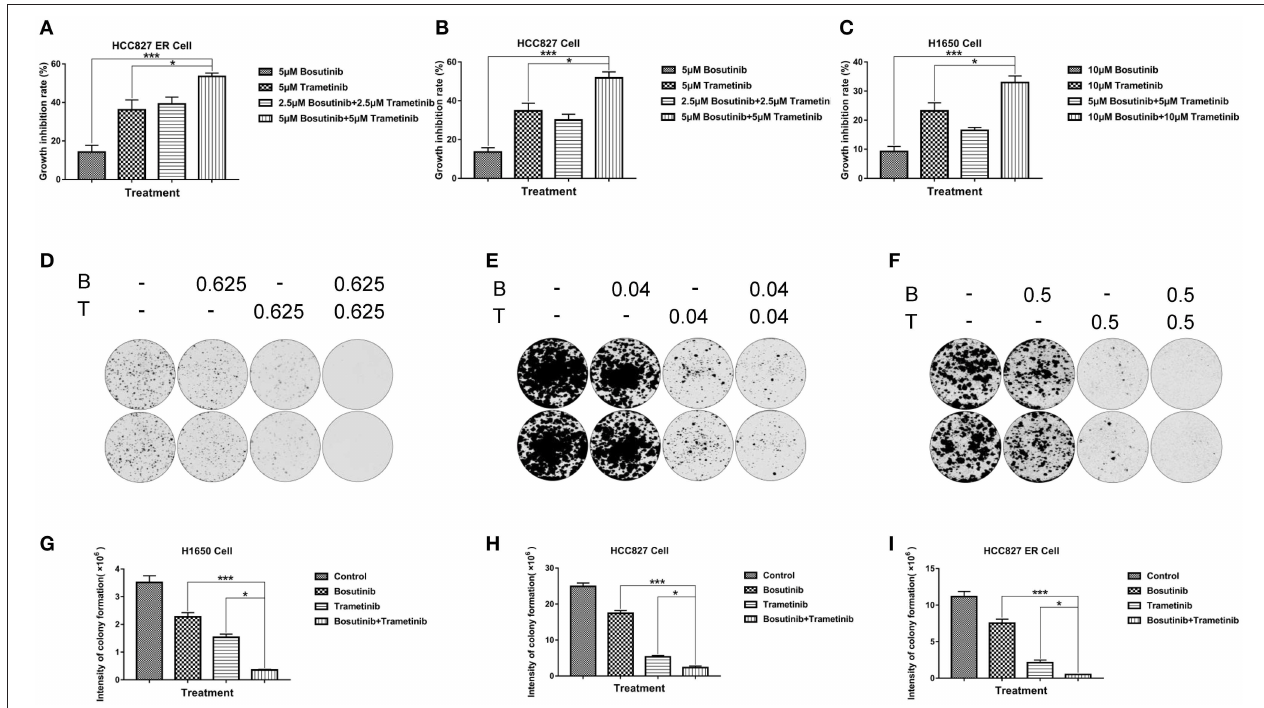
FIGURE 2 | The combination of trametinib with bosutinib synergistically reduced the viability of NSCLC in vitro. (A) H1650, (B) HCC827, and (C) HCC827 ER cell lines were seeded in 96-well plates. Trametinib, bosutinib, or their combination was added for 24h. Cell viability was determined using the MTT assay. (D) H1650, (E) HCC827, and (F) HCC827 ER cell lines were seeded at specific cell densities in six-well plates and were incubated overnight. The cells were treated with different concentrations of trametinib, bosutinib, or their combination for 24h. Then, the media were replaced with complete medium without drugs, and the cells were cultured for 14 days. Histograms of quantitative analysis of the colony formation assay: (G) H1650, (H) HCC827, and (I) HCC827ER cell lines. The data are presented as mean ± S.D. * P < 0.05, *** P <